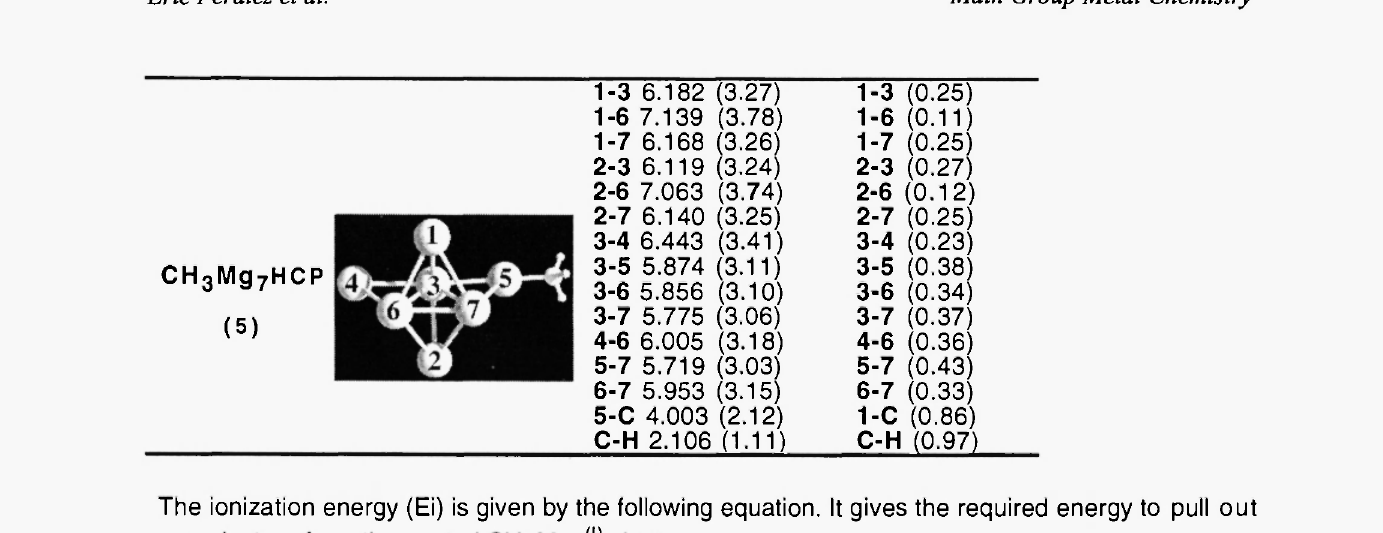
Ei = Ionization energy of the CH 3 Mg n <') cluster EiCHaMg^ 1 ' 1 + ) = Total energy of the cationic cluster E(CH3Mg n ('>) = Total energy of the neutral cluster η = Atom number of the Mg n cluster